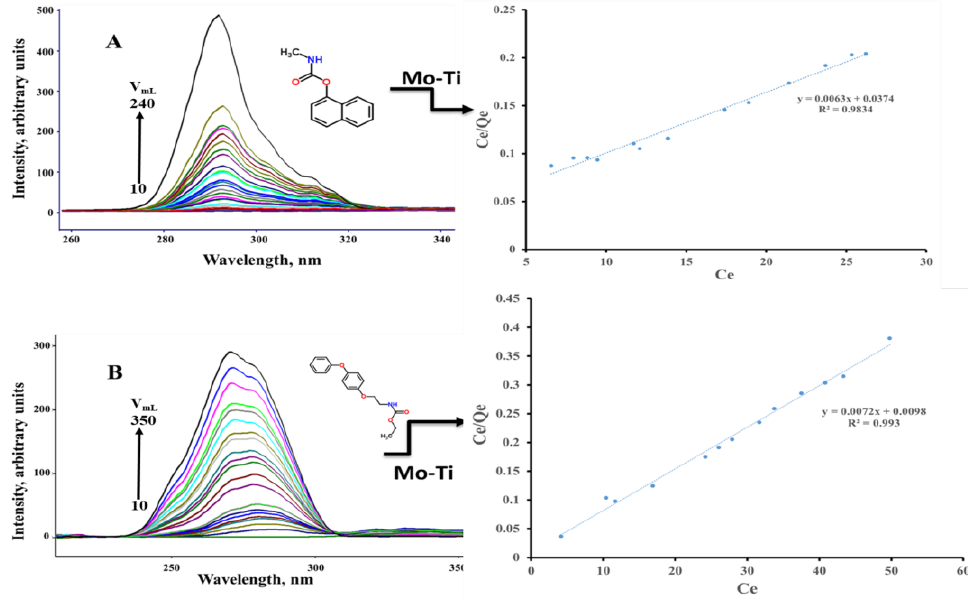
Figure 10. SSLS of the studied pesticides along with the Langmuir adsorption profile obtained for ( A ) carbaryl and ( B ) fenoxycarb.